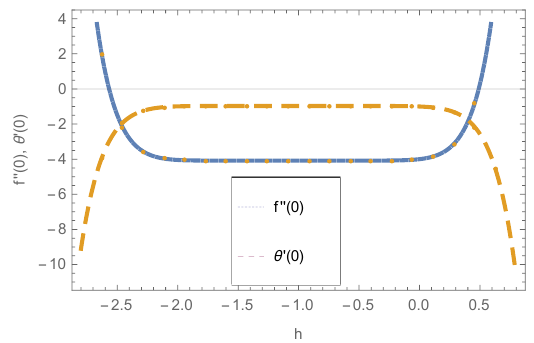
Figure 17. HAM’s